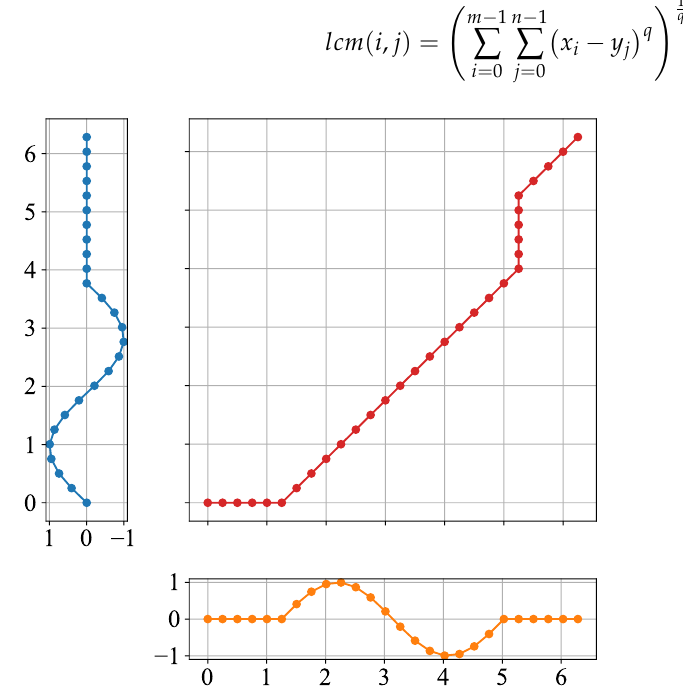
Figure 13. Alignment on local cost matrix. With LCM, two time series data are aligned. We find a path π (upper-right red line in Figure 13) of length max ( m , n ) from lcm ( 0, 0 ) to lcm ( m , n ) , which represents the